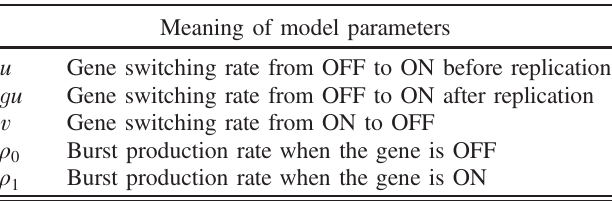
TABLE IV. Model parameters that are not included in Table I and their